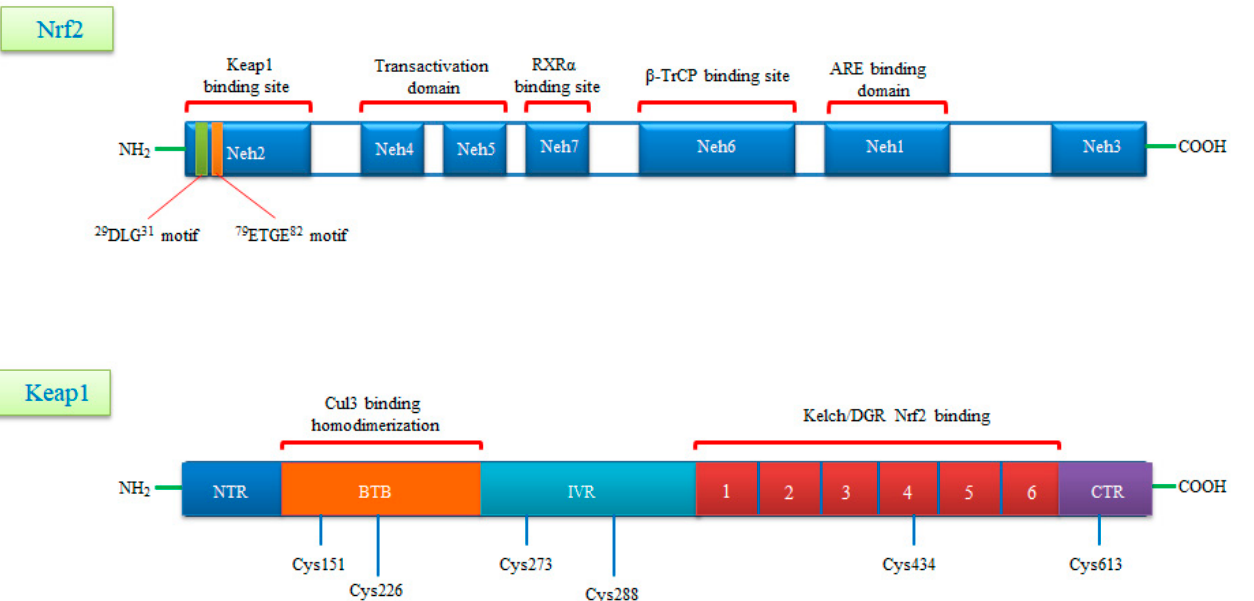
Figure 1. A schematic diagram of domain structures of Nrf2 and its repressor Keap1. Nrf2 consists of seven conserved domains known as Neh1-Neh7 and 605 amino acids. Neh1 interacts with small Maf (sMaf) proteins thanks to its Zip motif and thus binds to ARE sequences in DNA. The Neh2 domain contains two motifs called DLG and ETGE and interacts with the Keap1 molecule. The Neh4 and Neh5 domains are the CBP binding sites. Neh6 is a serine-rich domain that is required for TrCP binding and regulates Nrf2 stability. Neh7 is required to bind RXR α and inhibits ARE gene activity. Keap1, rich in cysteine residues, consists of five domains known as NTR, BTB, IVR, DGR, CTR and 624 amino acids. The BTB domain provides homodimerization of Keap1 and is the binding site for Cullin3 (Cul3). The N-terminal region of the IVR domain mediates these functions and acts as a sensor for Nrf2 inducers. The Kelch/DGR domain inhibits the multiple ubiquitination of Nrf2 by mediating the binding of Nrf2 to the Neh2